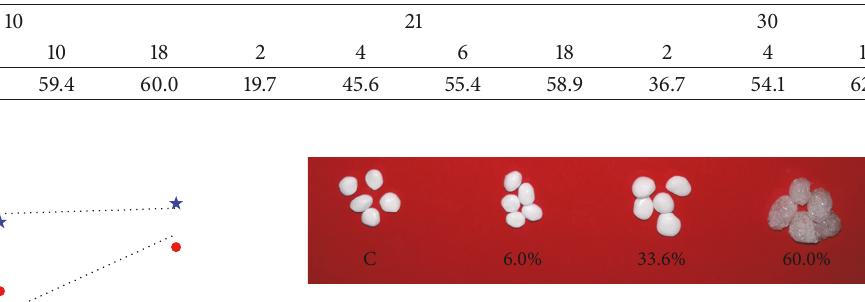
Figure 4: Effect of carvacrol loads on the swelling and agglomera- tion of CA